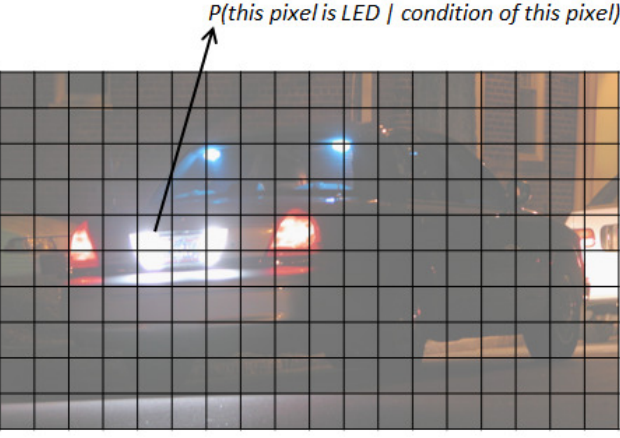
Figure 5. Concept of a probability-based tracking